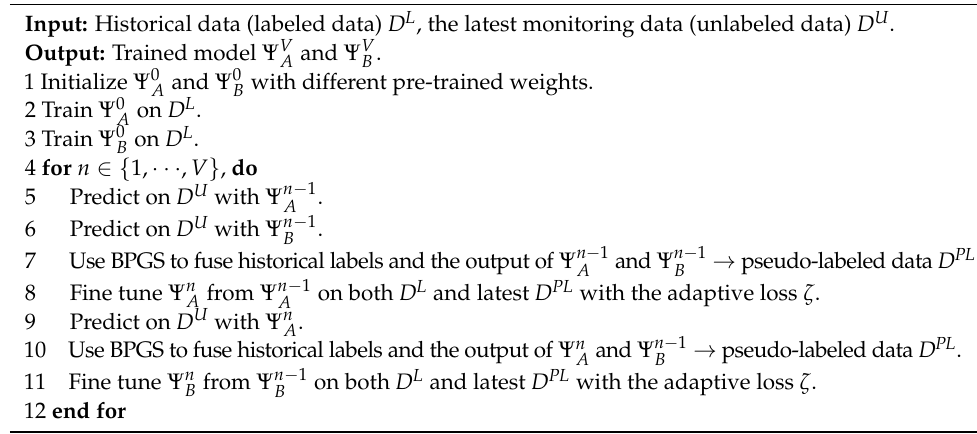
Algorithm 1 Iterative Training